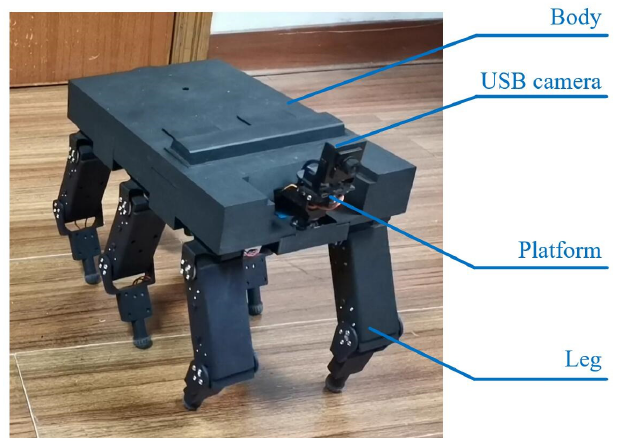
Figure 1. Picture of HexWalker II.